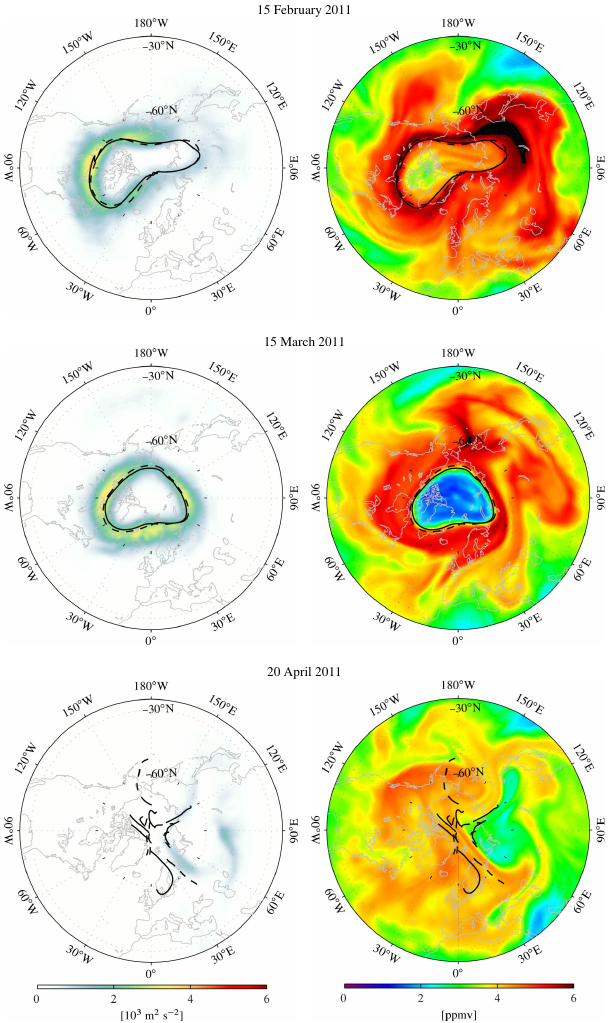
Fig. 1. Stratospheric wind kinetic energy per unit mass (left col- umn) and ozone mixing ratio (right column) on the 475K isentropic surface (at approximately 20km altitude) over the boreal polar re- gion on three days in 2011. The days selected are representative of typical behavior in mid-winter, near the winter–spring transition and in mid-spring. Superimposed on each plot are the positions of FTLE (finite-time Lyapunov exponent) trenches, computed in both forward time (solid curves) and backward time (dashed curves) rela- tive to the date indicated on the plots; when solid and dashed curves coincide, a transport barrier is present at the location of the overlap- ping